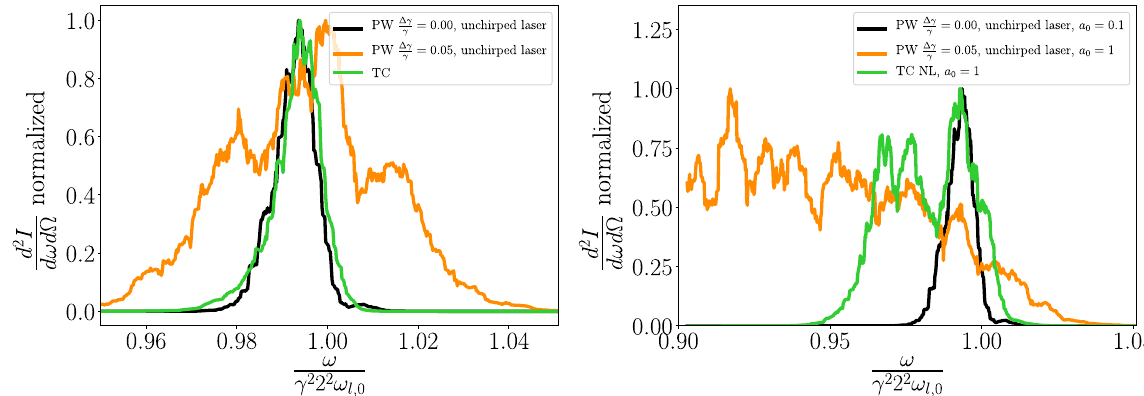
], N c ¼ 150 , s ¼ 10 3 , σ ¼ 15 × 10 − 4 ½ cm (cid:2) , σ ¼ 15 . 75 × 10 − 4 ½ cm (cid:2) , γ ¼ 10 3 where the energy e x;y z ¼ 0 . 05 and the electrons do not have initial transverse momentum. Left: laser γ